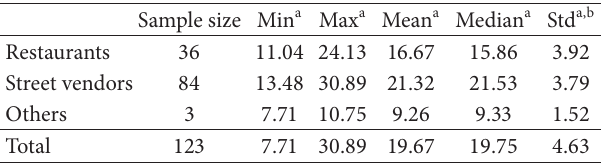
Table 1: Fat content of FBS collected from different vendors. Table 2: Moisture content of FBS collected from different